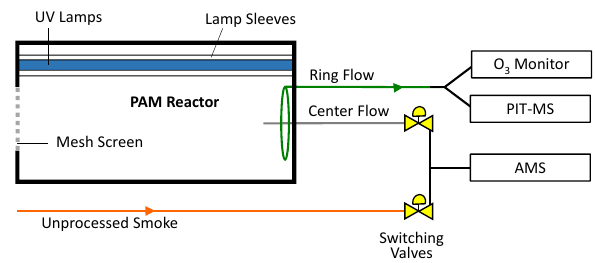
Fig. 1. Schematic of the potential aerosol mass (PAM) reactor cou- pled to an Aerodyne high-resolution time-of-flight aerosol mass spectrometer (AMS), proton-transfer-reaction ion-trap mass spec- trometer (PIT-MS), and ozone (O 3 ) monitor. A copper bypass line (orange) allows for direct sampling of unprocessed smoke. Computer-controlled switching valves (yellow) alternate between AMS measurements from the flow reactor and the bypass line. Volt- age supplied to UV lamps (blue) can be varied to control oxidant concentrations in the chamber. Ring flow (green) is a Teflon line and is used for gas-phase measurements; center flow (gray) is a stainless steel line that continuously extracts the sample for aerosol measure-